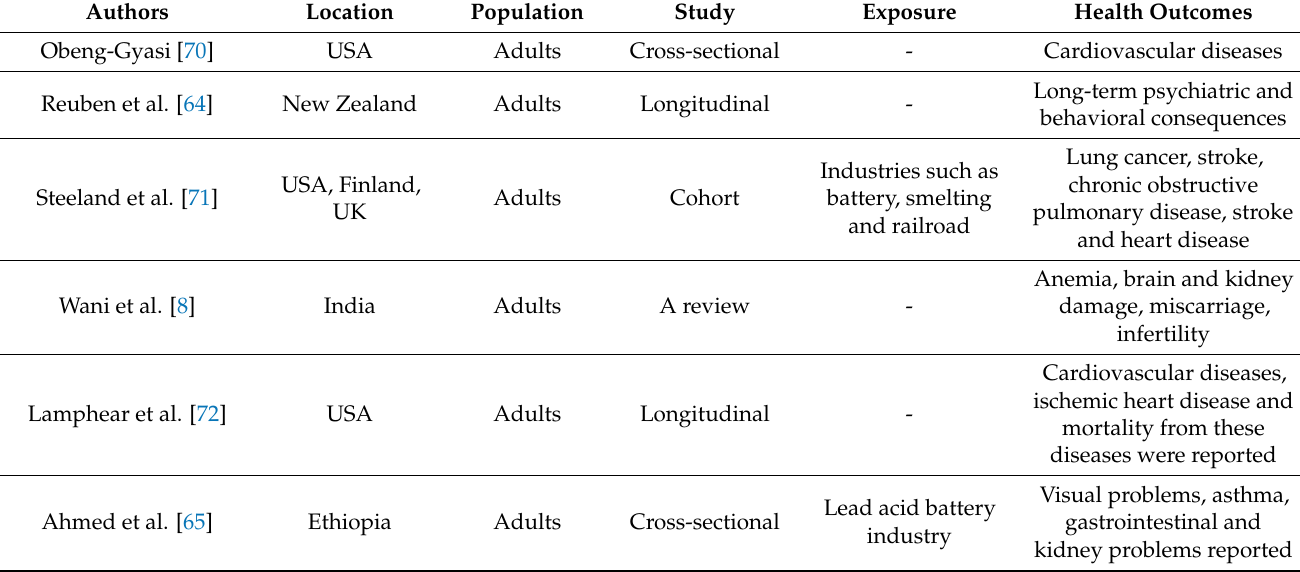
Table 3. Summary of epidemiological and scientific studies on health effects of lead exposure on adults from different